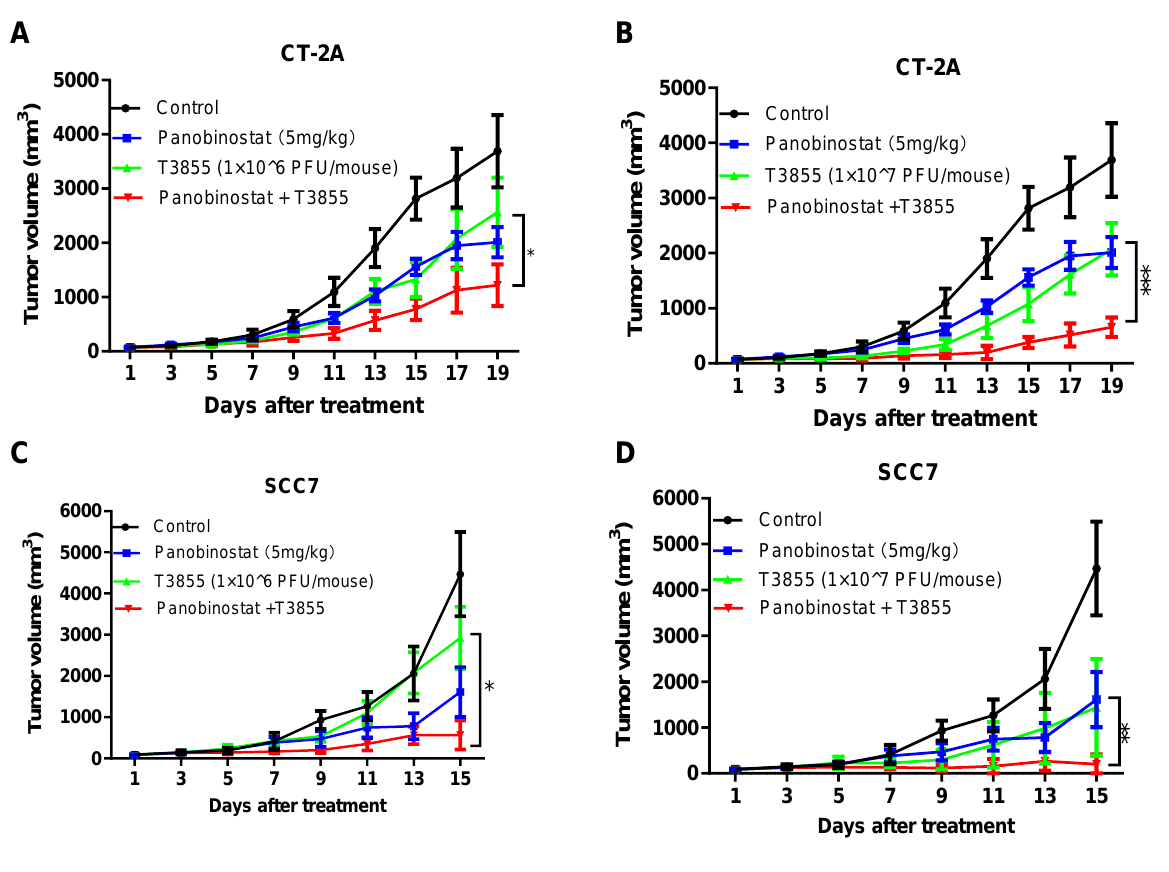
Figure 6. HDACi panobinostat and oHSV T3855 combination therapy further enhanced the antitumor efficacy in the murine glioma and squamous cell carcinoma models. CT-2A ( A , B ) or SCC7 ( C , D ) tumor cells were injected s.c. into the right flanks of syngeneic mice, respectively. Different tumor models averaging 80 mm 3 ( n = 8 per group) were treated via intratumoral injection with PBS or T3855 (1 × 10 6 or 1 × 10 7 PFU/animal) on Day 1, and HDACi (panobinostat; 5 mg/kg) or the vehicle was given via intraperitoneal injection with a five-day-on and two-day-off regimen for two weeks. The tumor volumes are shown as the mean ± SEM of eight animals in each group. Differences between datasets were assessed by Student’s t -test (two-tailed) using GraphPad Prism software. * p < 0.05, ** p < 0.01, *** p < 0.001.